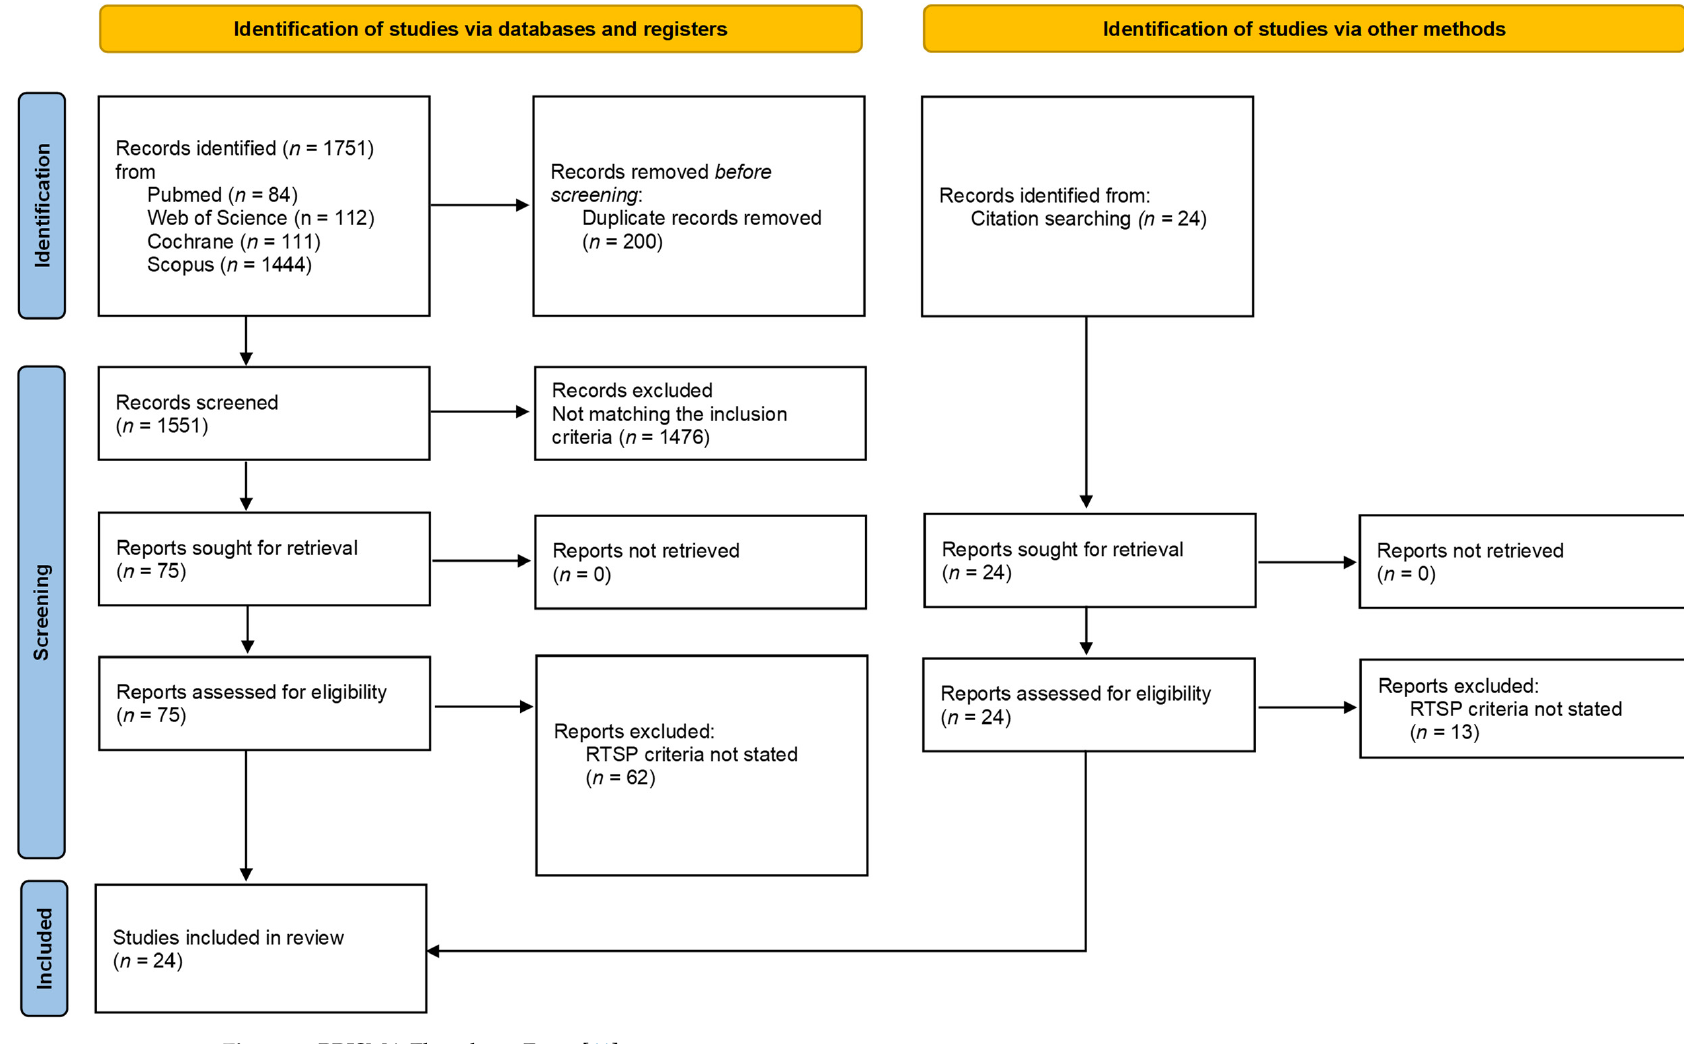
Figure 1. PRISMA Flowchart . From [41] .